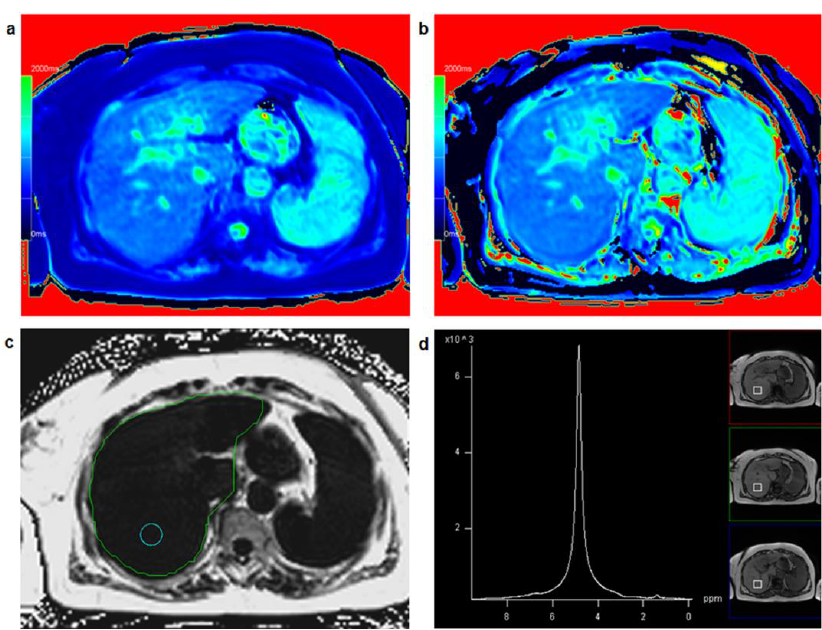
Figure 2. A 67-year-old female patient: T1 mapping from in-phase signal ( a ) and water-only signal ( b ) yielded similar T1 relaxation times for T1_in (= 912 ms) and T1_W (= 929 ms) suggesting low fat fraction in the liver with a fat fraction calculated from T1 mapping FF_T1 = 1.9%. Comparing T1_in and T1_W maps with identical window and center settings yields very similar color impression of the liver. PDFF mapping in a circular region of interest ( c ) resulted in PDFF = 1.1%, PDFF_MRS in a co-localized voxel ( d ) was 1.7%.